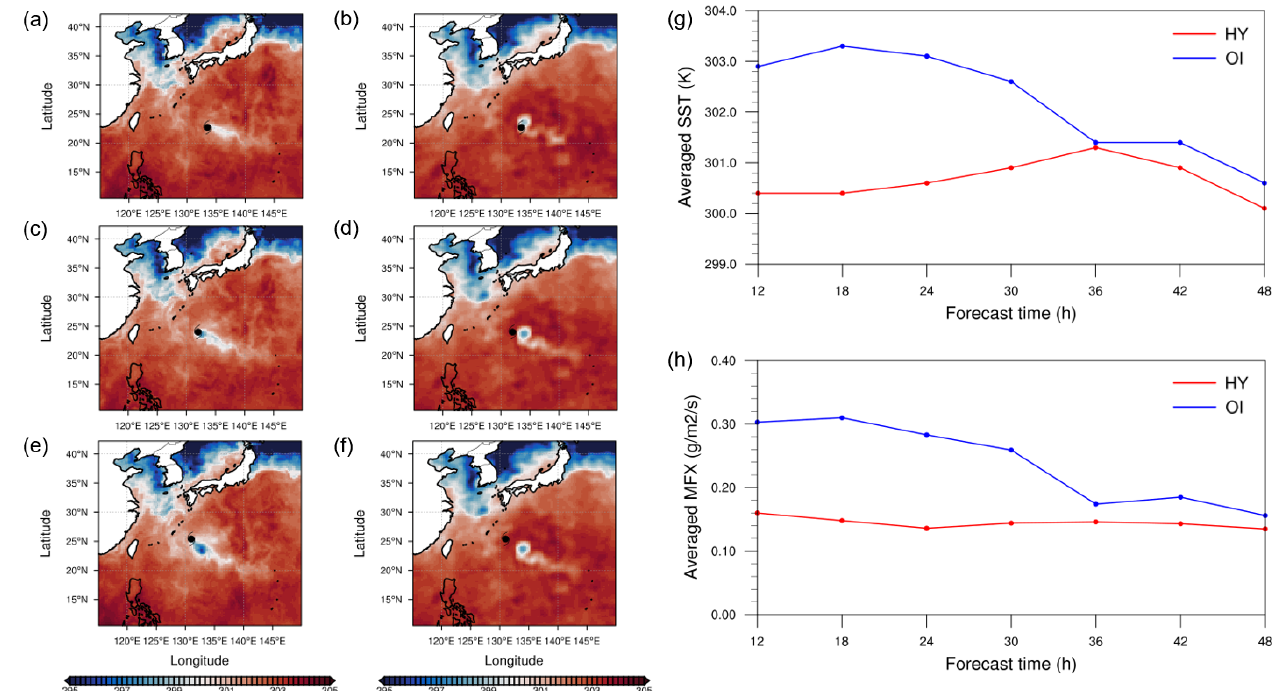
Figure 5. Horizontal distribution of SST (K, shading) in the ( a , c , e ) HYCOM and ( b , d , f ) OISST data from 12 UTC 4 September to 12 UTC 5 September 2020 at 12 h intervals. Time series of averaged ( g ) SST (K) and ( h ) upward moisture flux (g m − 2 s − 1 ; MFX) near typhoon Haishen from 00 UTC 5 September 2020 to 12 UTC 6 September 2020. Blue: OI run, red: HY run. Black marks represent typhoon location at that time.